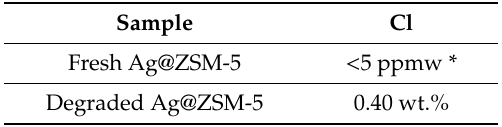
Table 1. Elemental analyses of chlorine in fresh and degraded